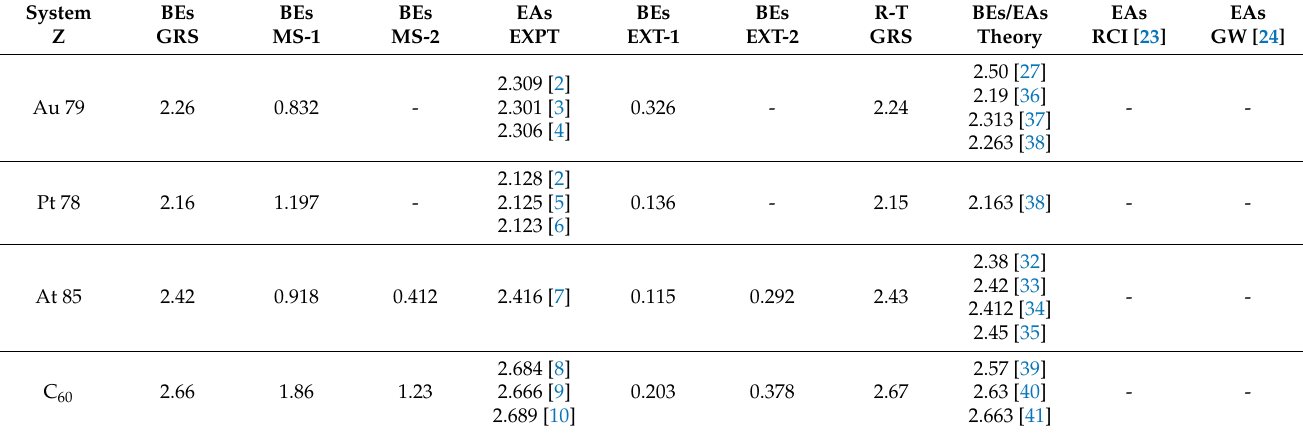
Table 1. Negative ion binding energies (BEs) and ground state Ramsauer–Townsend (R-T) minima, all in eV extracted from TCSs of the atoms and the fullerene molecules C 60 and C 70 . They are compared with the measured electron affinities (EAs) in eV. GRS, MS- n, and EXT- n ( n = 1, 2) refer, respectively, to ground, metastable, and excited states. Experimental EAs, EXPT, and theoretical EAs, theory is also included. The numbers in the square brackets are the